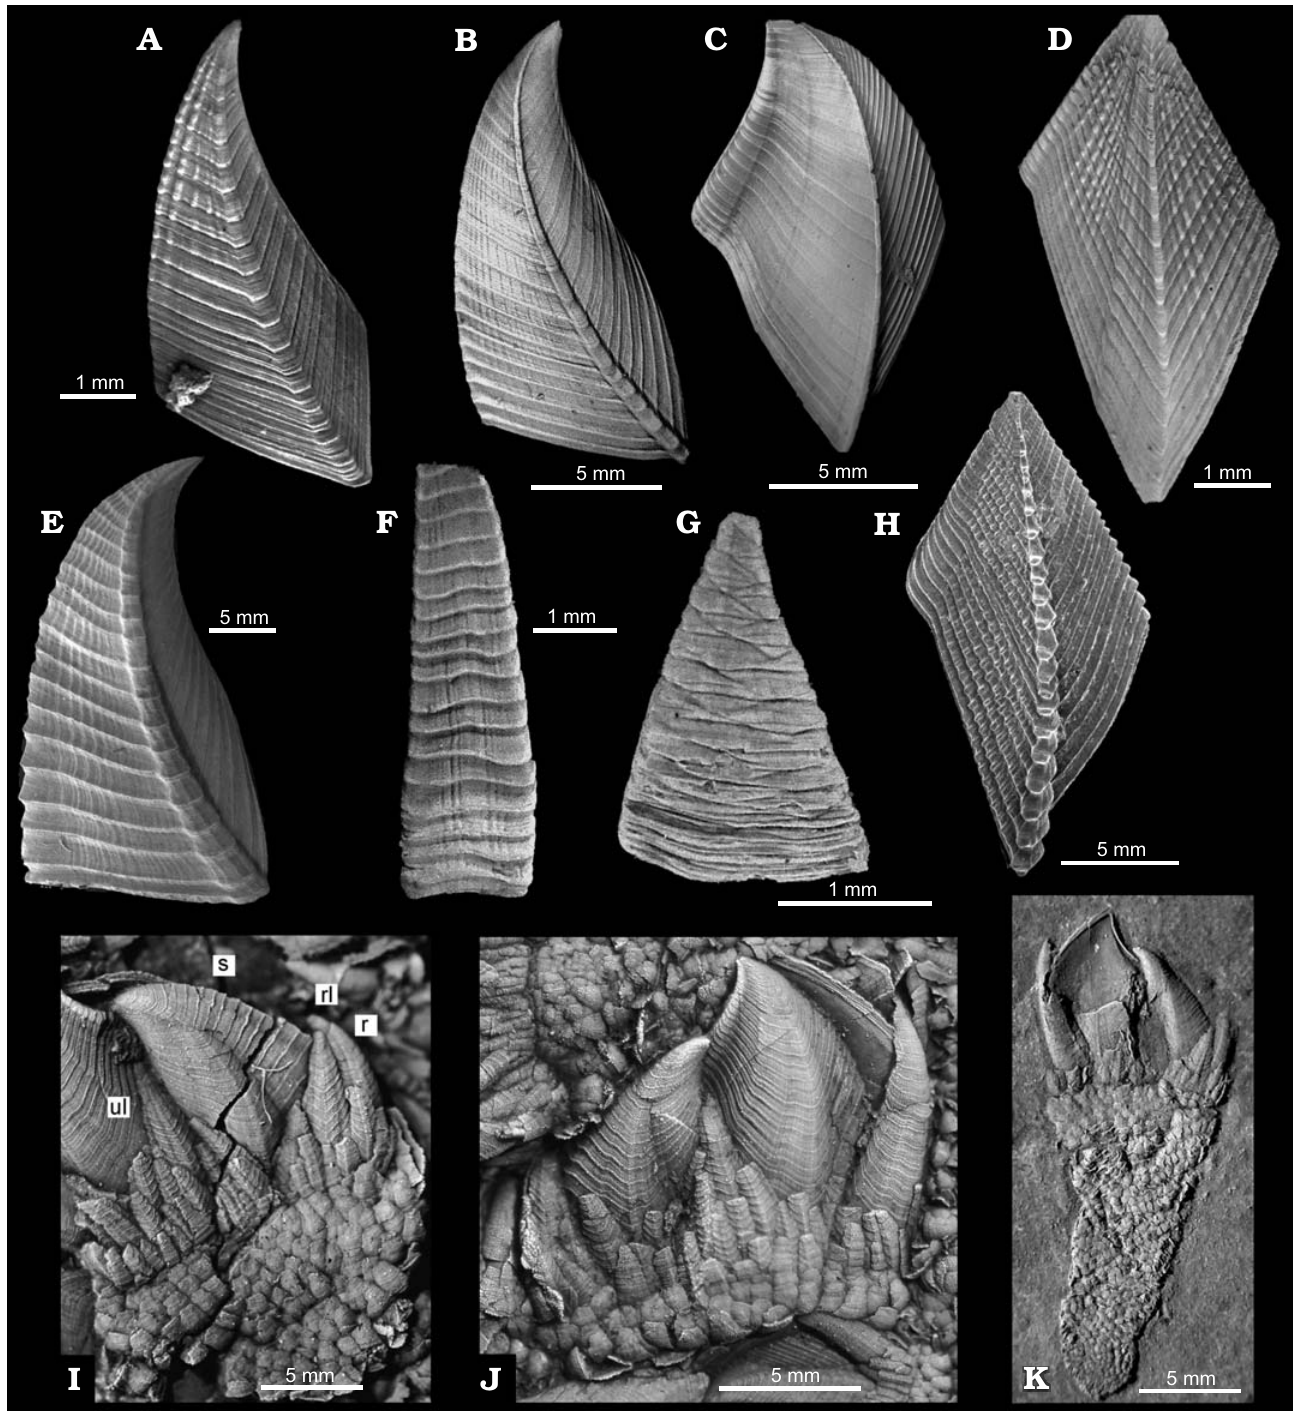
Fig. 5. Comparative morphology of neolepadid cirripede Ashinkailepas indica Gale sp. nov. (A, D, G) from Late Pleistocene, Krishna-Godavari Basin, off shore India, and other cirripedes. A . NHMUK IC 1412, paratype, scutum. D . NHMUK IC 1410, paratype, tergum. G . NHMUK IC 1404, paratype, upper latus. B , C , F . Brachylepadid Pycnolepas rígida (J. de C. Sowerby, 1836) from Gault Clay, Upper Albian (Lower Cretaceous), Naccolt, Kent, UK (based on B, Gale 2014b: fig. 4S; C, Gale 2014b: fig. 4Q; F, Gale 2014b: fig. 4R). B . NHMUK IC 1034, scutum. C . NHMUK IC 1032, tergum. F . NHMUK IC 1033, upper latus. E . Brachylepadid Faxelepas bruennichi (Withers, 1914) from Paleocene, Danian, Faxe, Denmark (based on Gale 2014b: fig. 6A). NHMUK IC 1019, scutum. H . Brachylepadid Pedupycnolepas pulcher Gale, 2019 from Endemoceras amblygonium Zone, Hauterivian (Lower Cretaceous), Engel- bostel, near Hannover, Germany (based on Gale 2019b: fig. 11B). NHMUK IC 1397, holotype, tergum. I – K . Zeugmatolepadid capitula of Etcheslepas durotrigensis Gale, 2014 from Pectinatites pectinatus Zone, Tithonian (Upper Jurassic), Freshwater Steps, Kimmeridge, Dorset, UK. I , J . MIJML coll. unnumbered (based on Gale 2019a: fig. 2C, D). K . MIJML K1261, holotype (based on Gale 2014a: fig. 1). All in external view. Abbreviations: r, rostrum; s, scutum; rl, rostrolatus; ul, upper